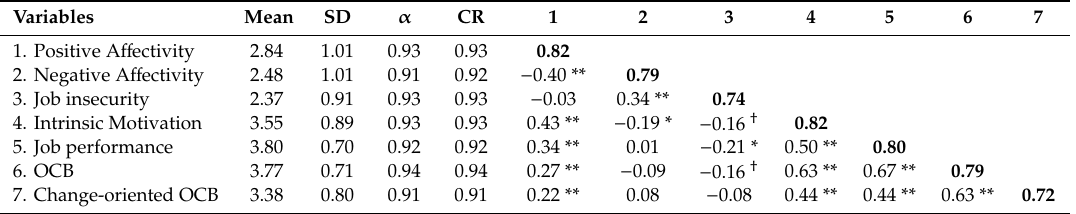
Table 2. Means, Standard Deviations, and